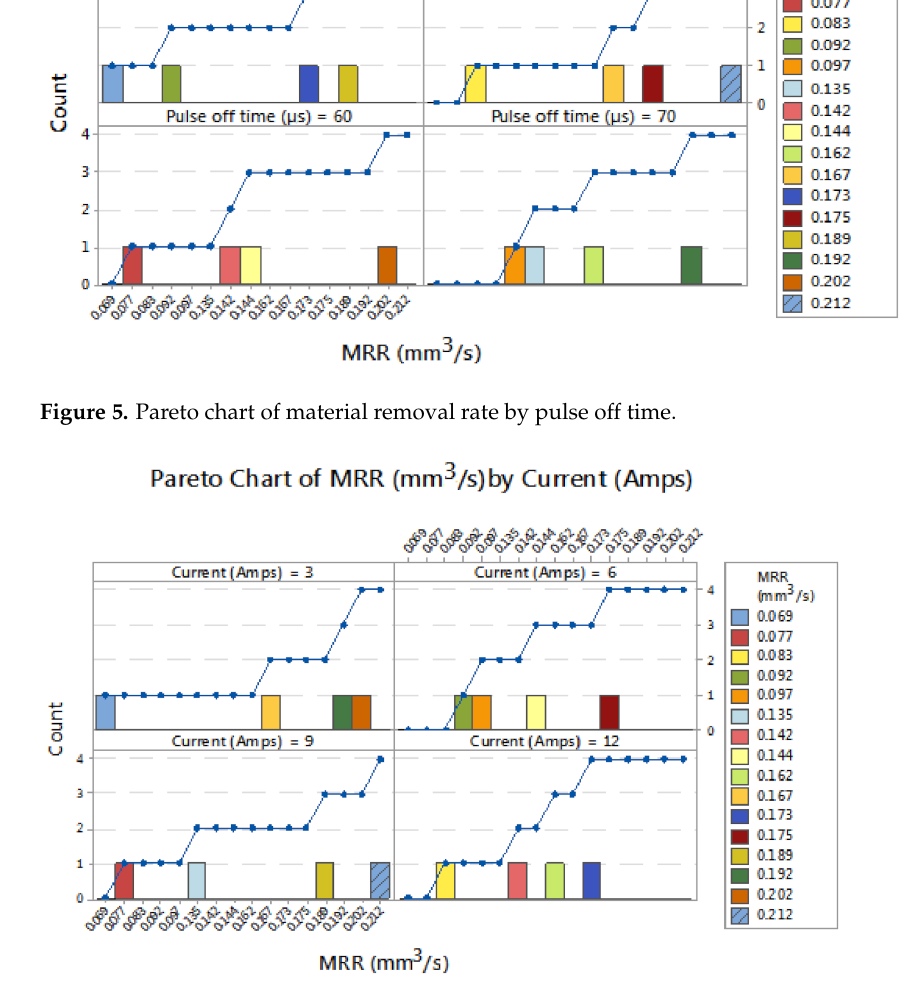
Figure 6. Pareto chart of material removal rate by current